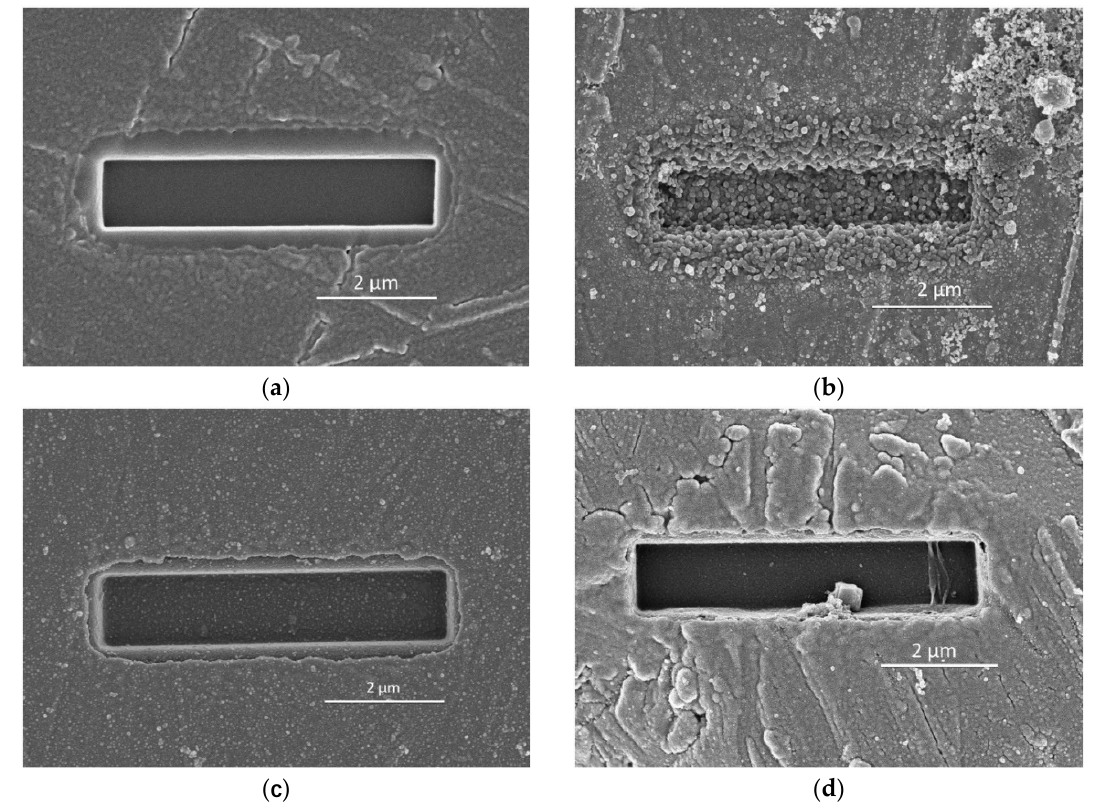
Figure 13. Micro-reactors: ( a ) gaps before immersion in solution, ( b ) after 2 days in 0.1 M KOH solution, ( c ) after 2 days in 0.1 M KOH + 20 mM CaCl 2 solution and ( d ) after 2 days in 0.1 M KOH + 60 mM NaAlO 2 solution. (cited from [55]).